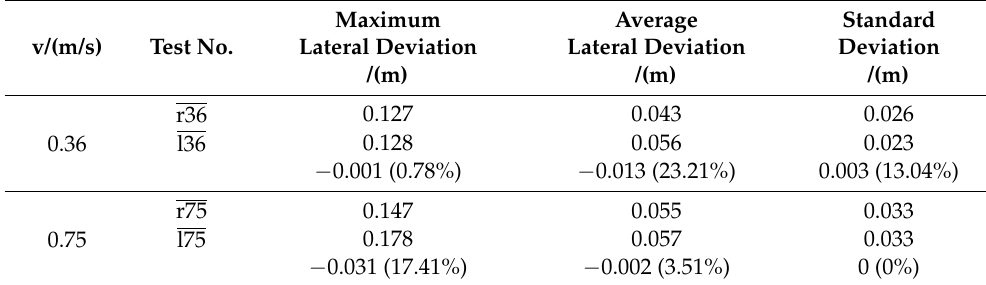
Table 6. Comparison of straight-line path-tracking accuracy.